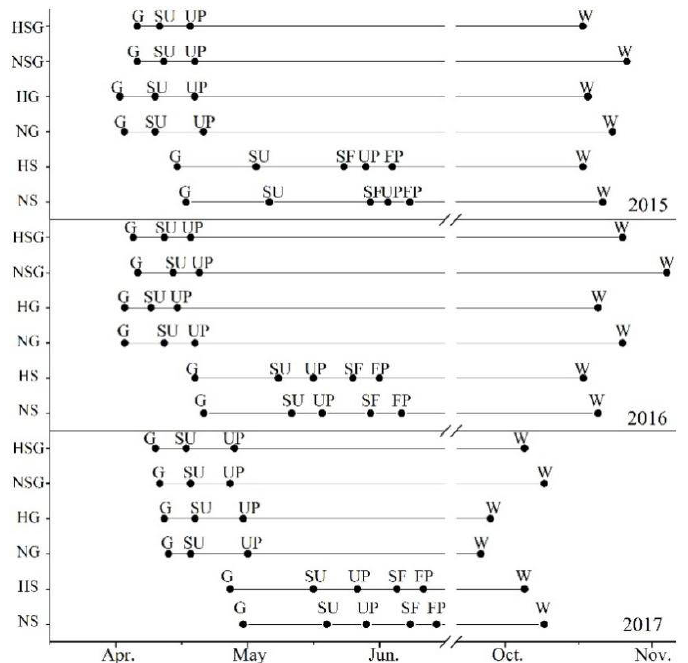
Figure 6. The phenologies of shrub and grass from 2015 to 2017. G: germination; SU: start of unfolding; UP: unfolding peak; SF: start of flowering; FP: flowering peak; W, withering. HSG: grass in harvesting shrub patch; NSG: grass in natural shrub patch.